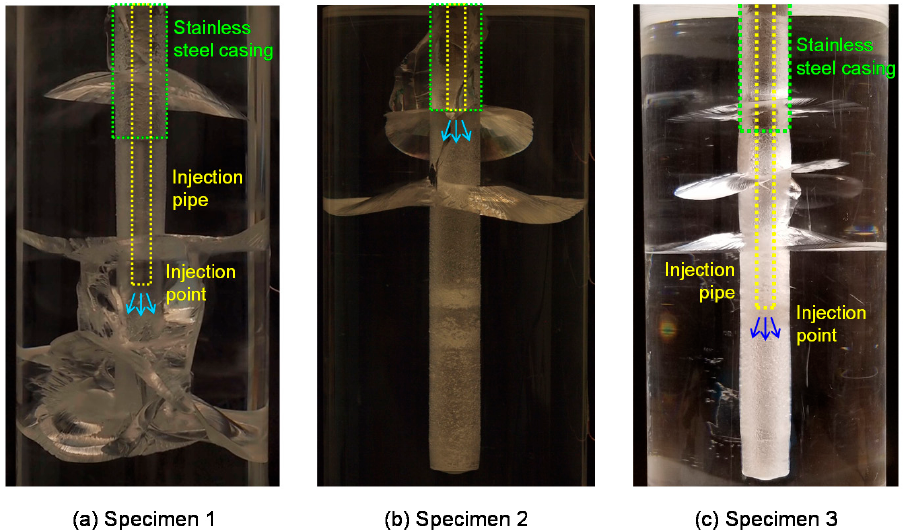
Figure 11. The locations of casings, inlet ports, and fractures.